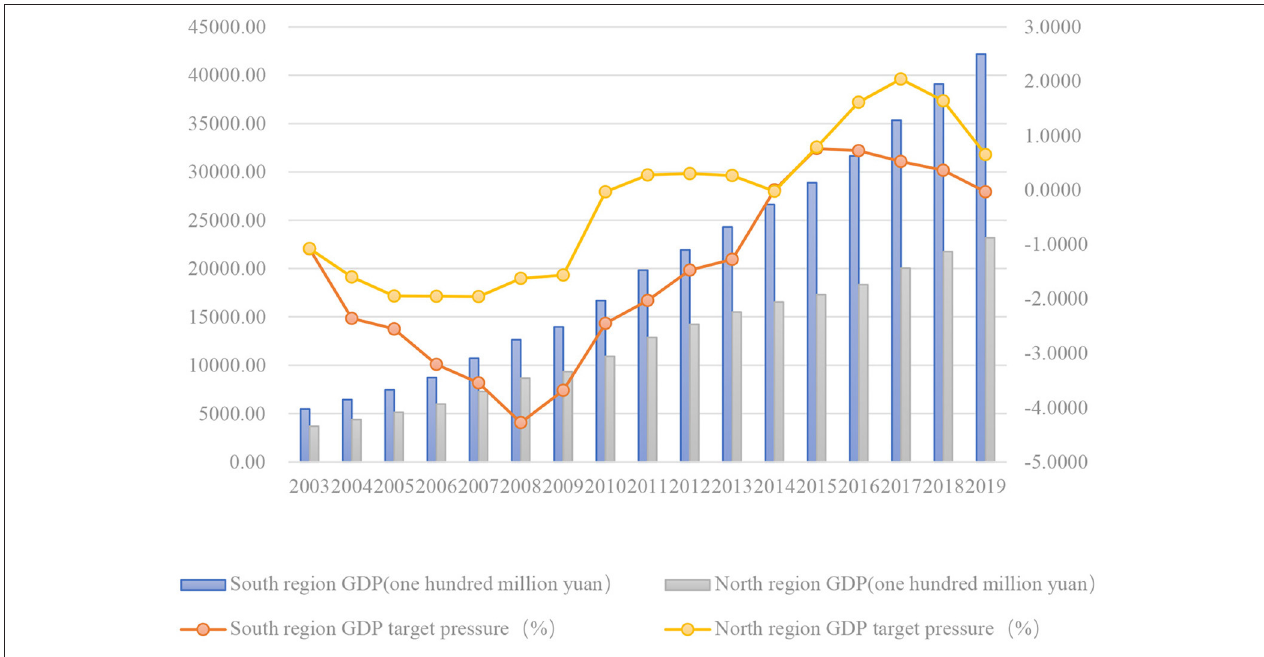
FIGURE 1 | GDP and GDP target pressure in south region and north